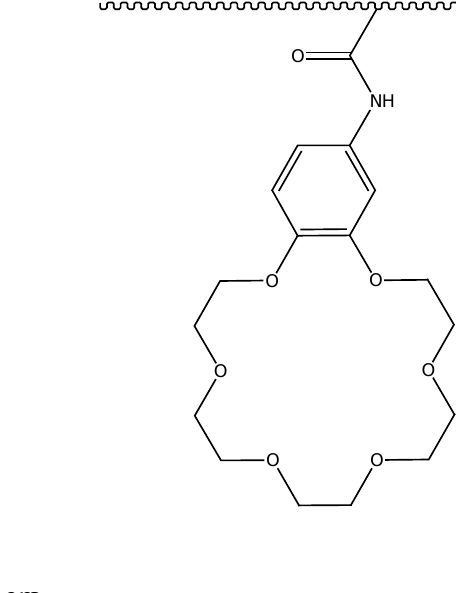
Figure 33. Methacrylic-acrylic